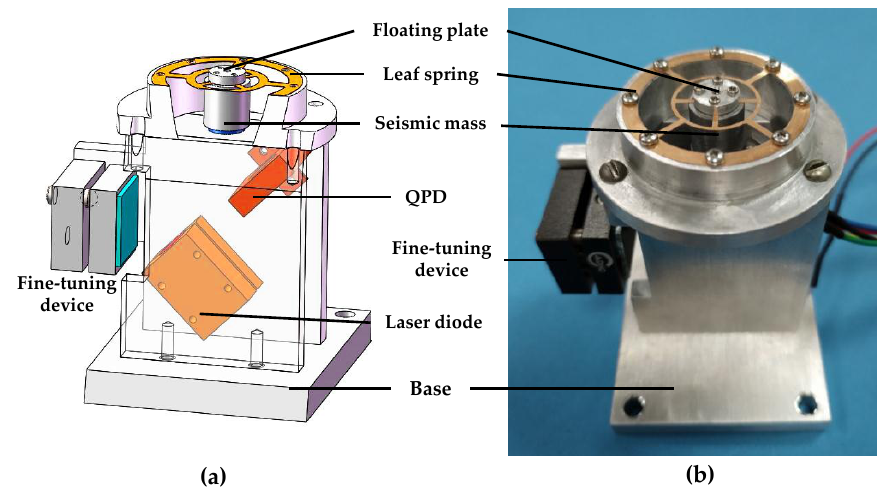
Figure 5. Optical accelerometer ( a ) internal schematic, ( b ) photo.